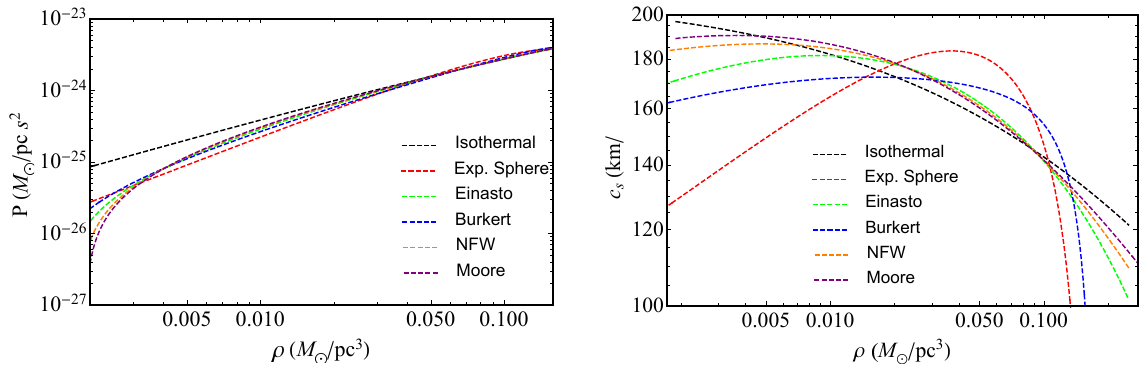
Figure 5. Color online. Left panel: The equation of state of DM halo. Right panel: The speed of sound for the DM fluid for different DM